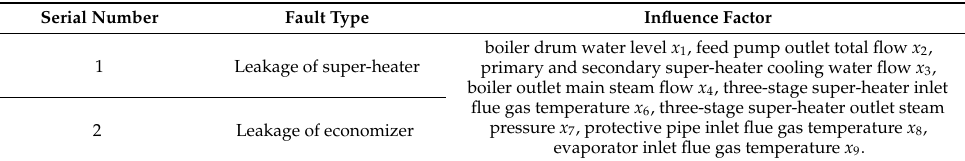
Table 1. Faults and influencing factors of steam-water system.